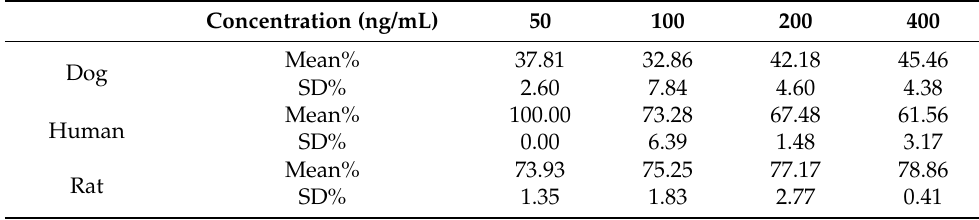
Table 4. Comparison of the plasma protein binding rate of HY-071085 in rats, dogs and